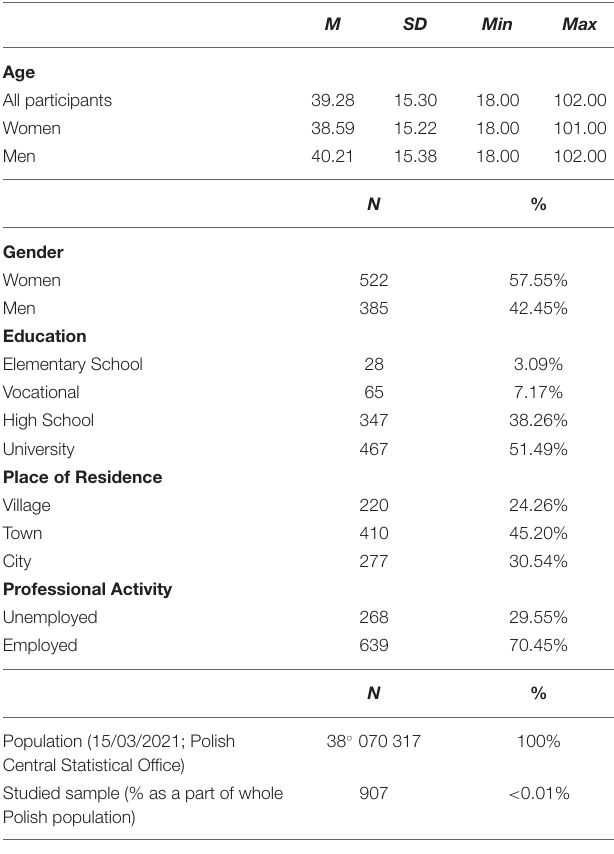
TABLE 1 | Characteristics of the studied sample ( N =